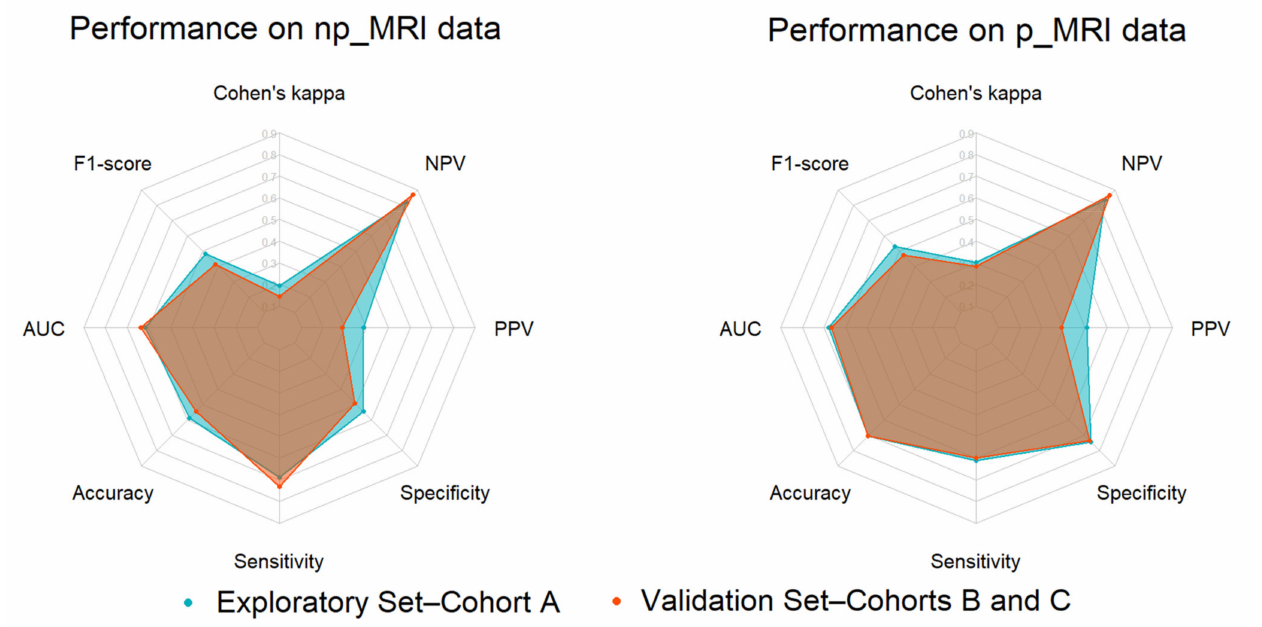
Figure 6. From left to right: Radar plots illustrating the IDH mutation status prediction performance during the model development (internal validation using the exploratory set) and validation (external validation set) phases from np_MRI and p_MRI data.